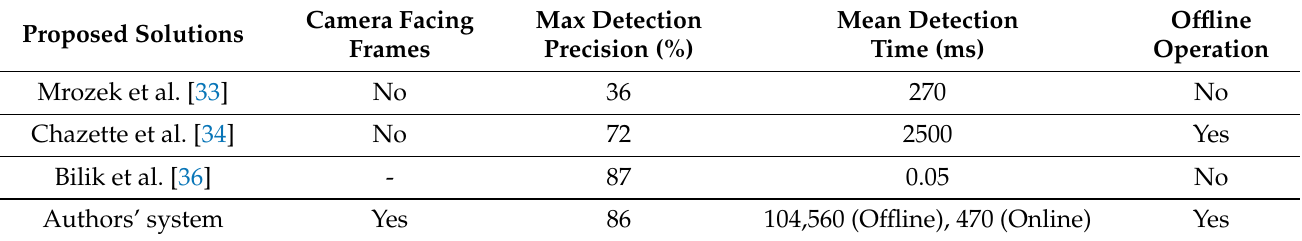
Table 7. Cross comparison of camera-based detection systems for the detection of